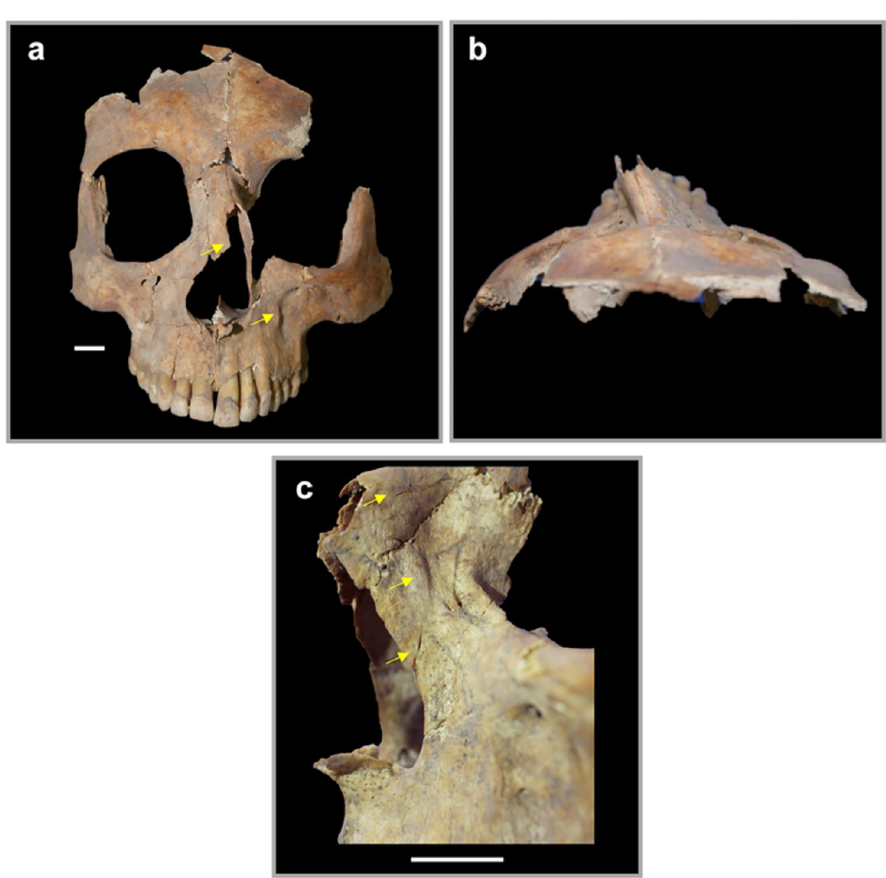
Fig 5. Facial trauma of Individual 1. a: Asymmetry of nasal region in anterior view, with arrows highlighting the abnormal shape of the anterior right nasal and the depression in the left maxilla. b: Asymmetry of nasals from superior view. c: The left maxilla in lateral view, with arrows highlighting healed fractures (top and bottom arrows) and the swelling of bone (center arrow). All scale bars are 1 cm.